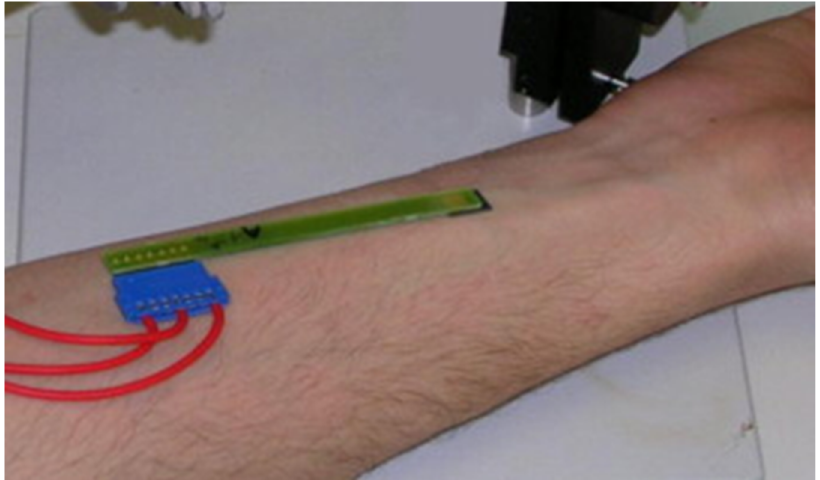
Figure 9. Use of the (Au–Pt–Ag/AgCl) electrochemical microcell for the skin analysis. Reproduced with permission from [50]. Copyright 2013 Elsevier.